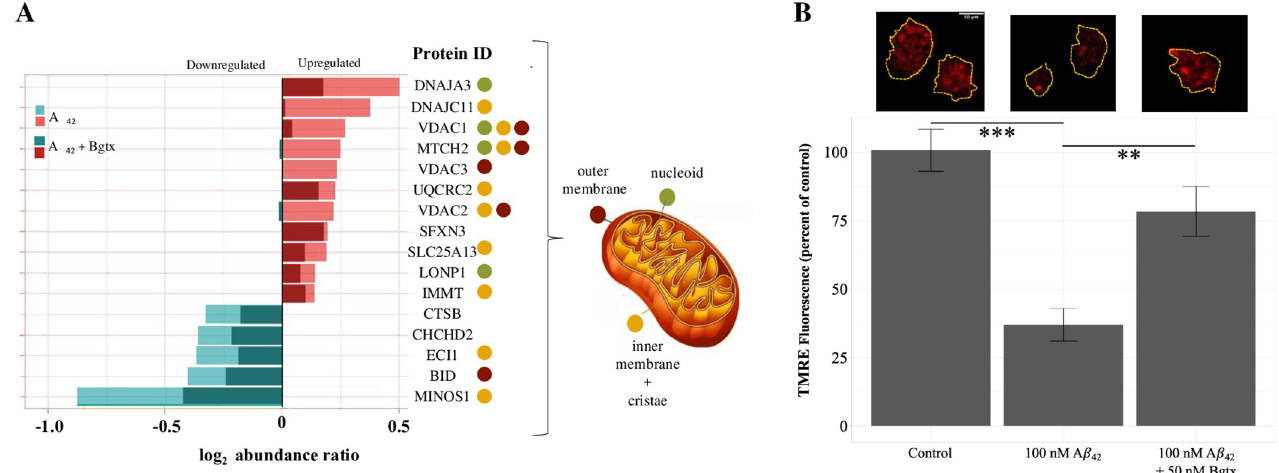
Fig 8. Mitochondrial proteins within Δ P. A) A change in protein level measured by the log 2 abundance ratio measures within A β 42 and A β 42 + Bgtx treatment conditions. Color shading highlights the impact of treatment on protein expression. Light (A β 42 ); dark (A β 42 + Bgtx). The known localization of each protein within the mitochondria is shown using colored dots. B) Top, representative images for each condition showing fluorescence intensity of TMRE. Bottom, average percent change in TMRE fluorescence. (n � 21). � p < 0.05; �� p < 0.01; p < 0.001.